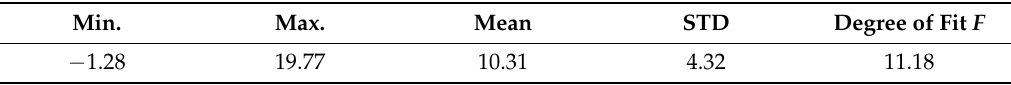
Table 2. Statistical characteristics of the difference between the observed gravity anomaly along the route and the gravity at the corresponding location of the reference map (unit: mGal). Min. Max.